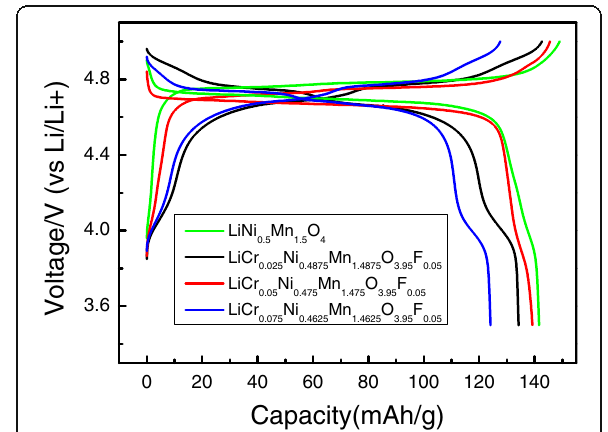
Fig. 4 TEM and HRTEM images of LiNi 0.5 Mn 1.5 O 4 ( a and b ) and LiCr 0.05 Ni 0.475 Mn 1.475 O 3.95 F 0.05 ( c and d )